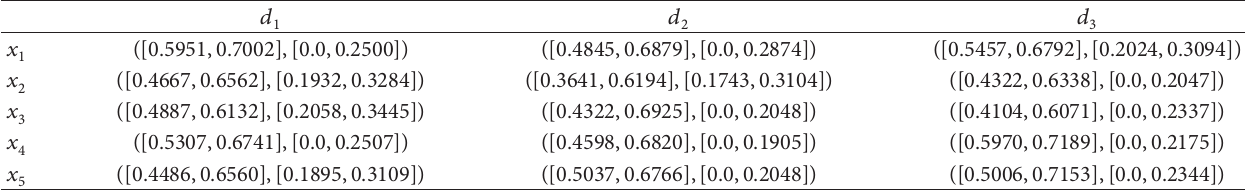
̇𝑅 obtained by utilizing P-GIIFOWA operator.